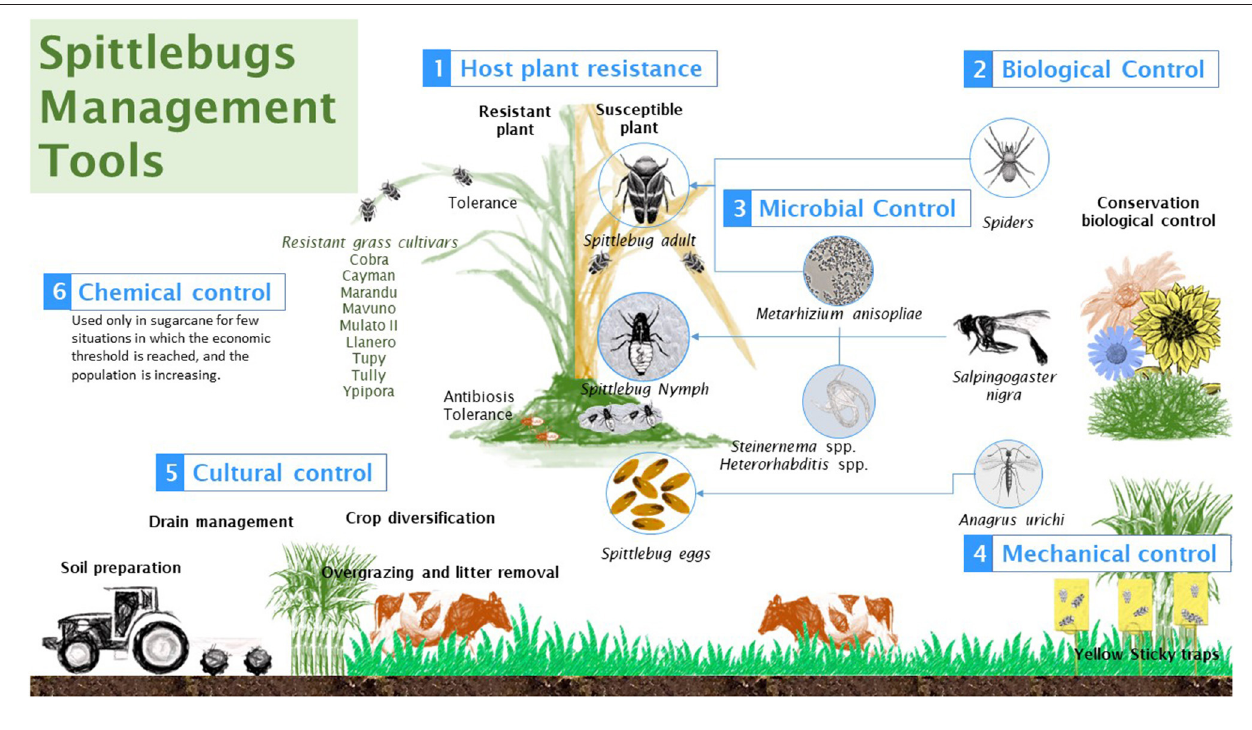
FIGURE 1 | Main tools used in integrated spittlebugs management program.